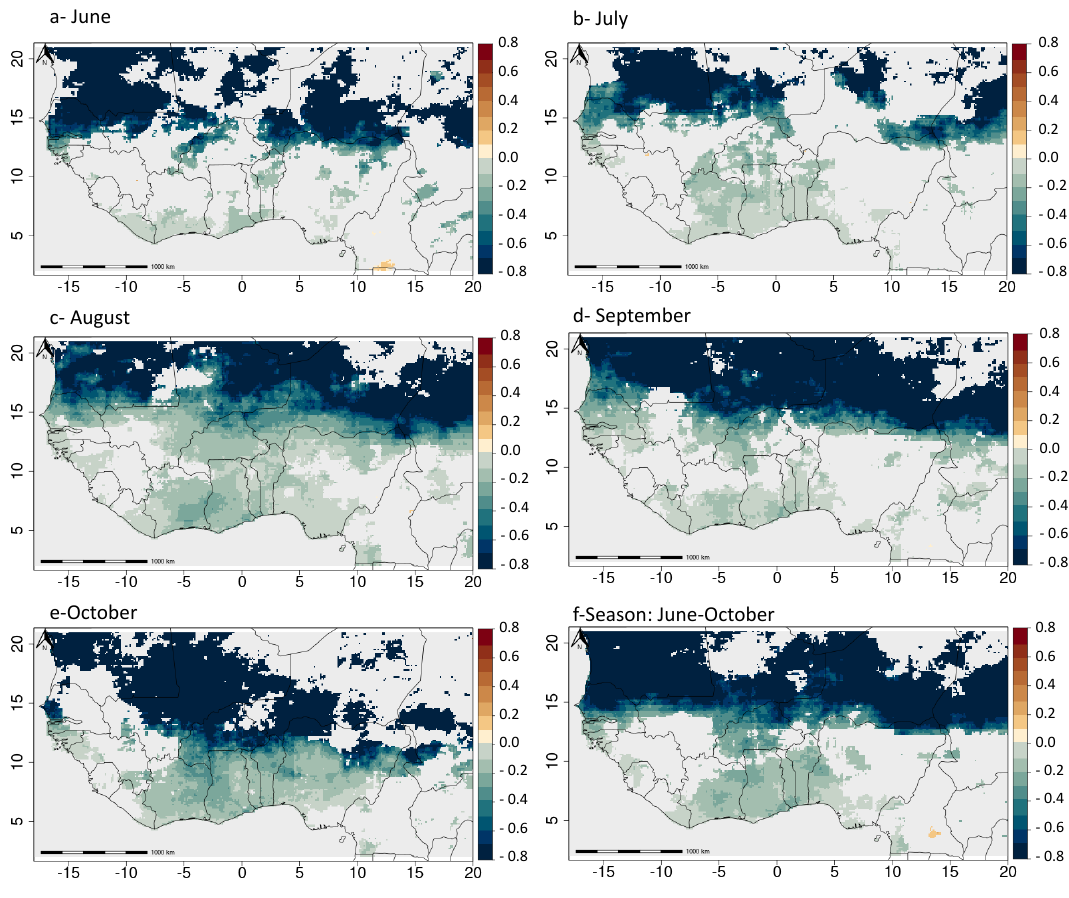
Figure 5. ET 0 regressed on precipitation, where precipitation is the independent variable and ET 0 is the dependent variable for the months of June ( a ), July ( b ), August ( c ), September ( d ), October ( e ), and full season ( f ) calculated from 1981 to 2016. Any insignificant slope ( p > 0.05) has been masked out in